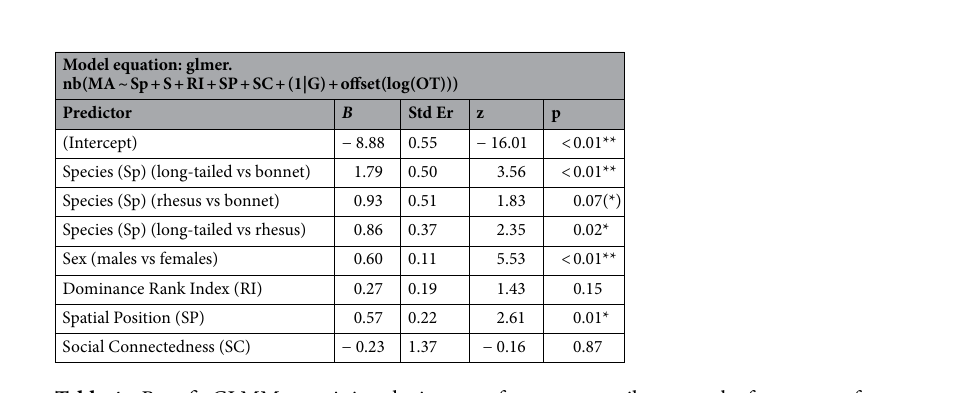
Table 4. Best-fit GLMM examining the impact of macaque attributes on the frequency of macaque-to-human aggression. Group (G) was a random effect, and observation time (OT) was an offset variable. **p < 0.01; *p < 0.05; (*) 0.05 < p < 0.1.